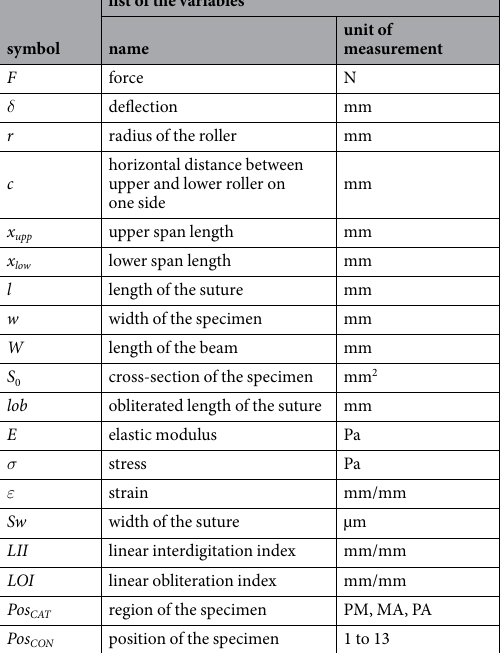
Table 2. List of the